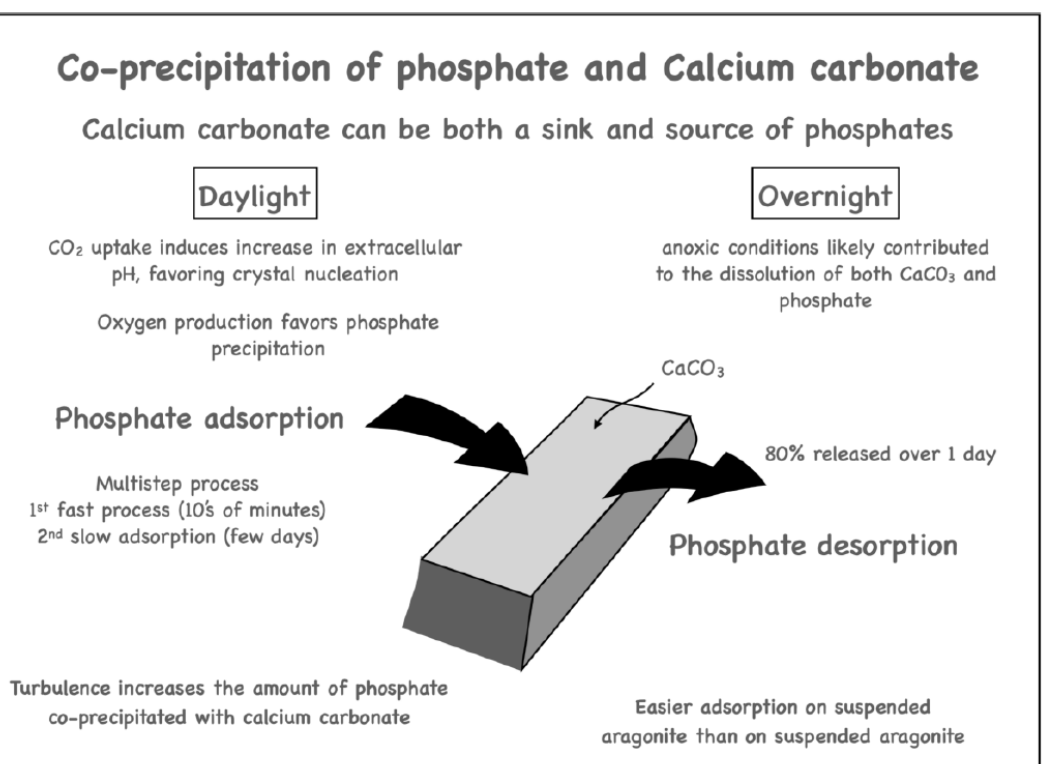
Figure 7. Co-precipitation of phosphate and calcium carbonate; note that phosphate is more readily adsorbed onto and released from aragonite than onto/from calcite ((This figure is an original interpretation by L. Pomar based on several sources, including [58 – 60]).